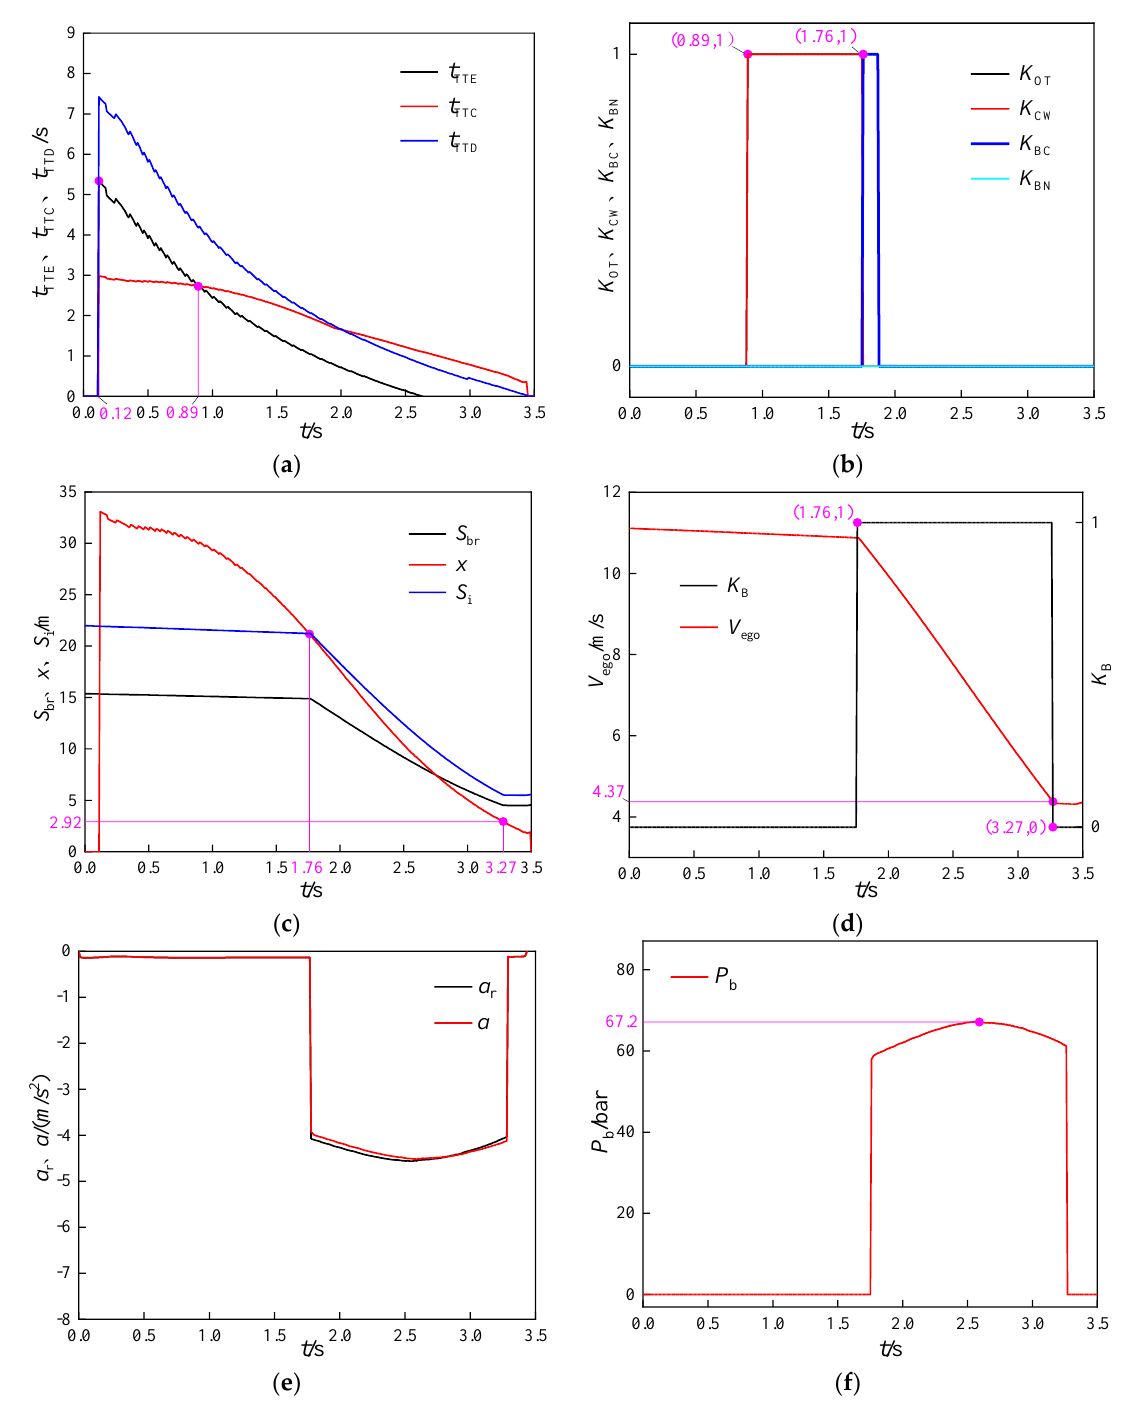
Figure 6. The simulation results of scenario 1. ( a ) The changes in t TT C , t TTE , and t TTD . ( b ) The changes in K OT , K CW , K BC , and K BN . ( c ) The changes in S br , x , and S i . ( d ) The changes in V ego and K B . ( e ) The changes in a r and a b . ( f ) The change in P .